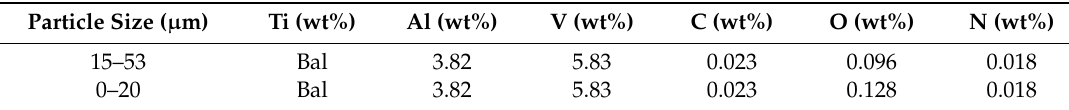
Figure 1. Properties of the Ti6Al4V powder; ( a ) the particle size distribution of original powder, ( b ) the microstructure of the pure powder, ( c ) the microstructure of mixed powder. Scale bar = 50 µ m. Table 1. Powder